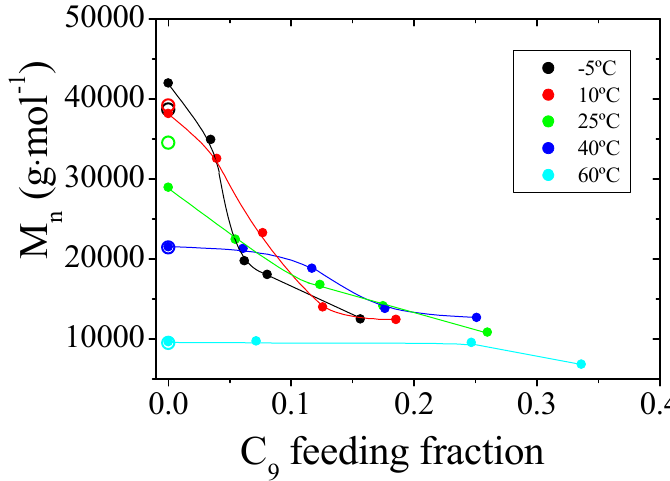
Figure 6. Variation of the number average molecular weight ( M n ) with the C 9 feeding molar fraction. Open symbols: M n from SEC; solid symbols: M n from 1 H NMR. A colour code is inserted into the